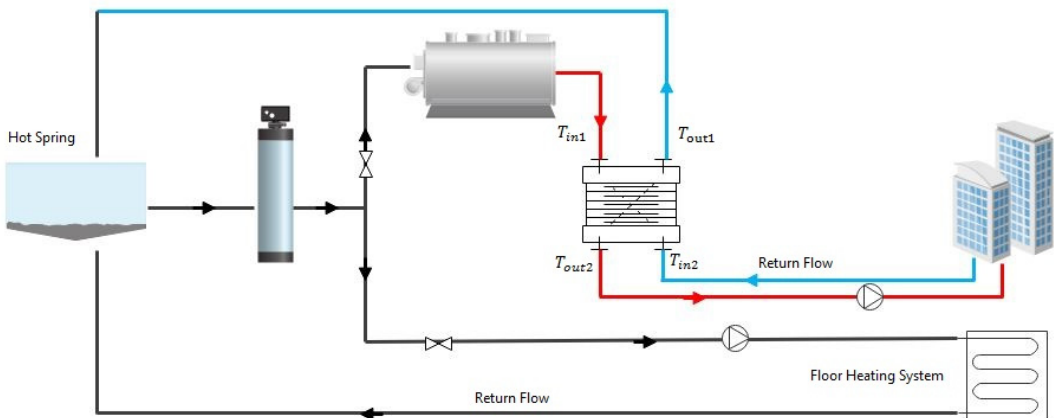
Figure 11. Simplified diagram of the DHS system in DHS-G scenario.